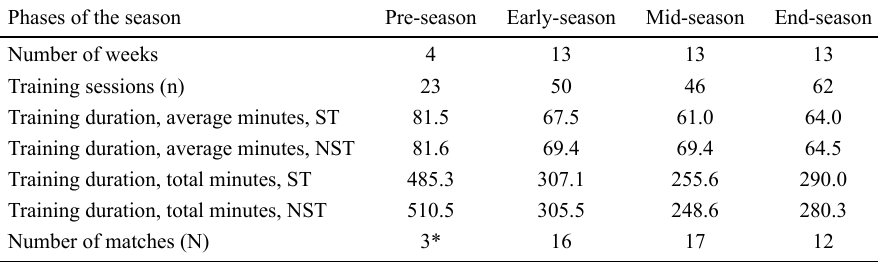
Table 1. Description of the